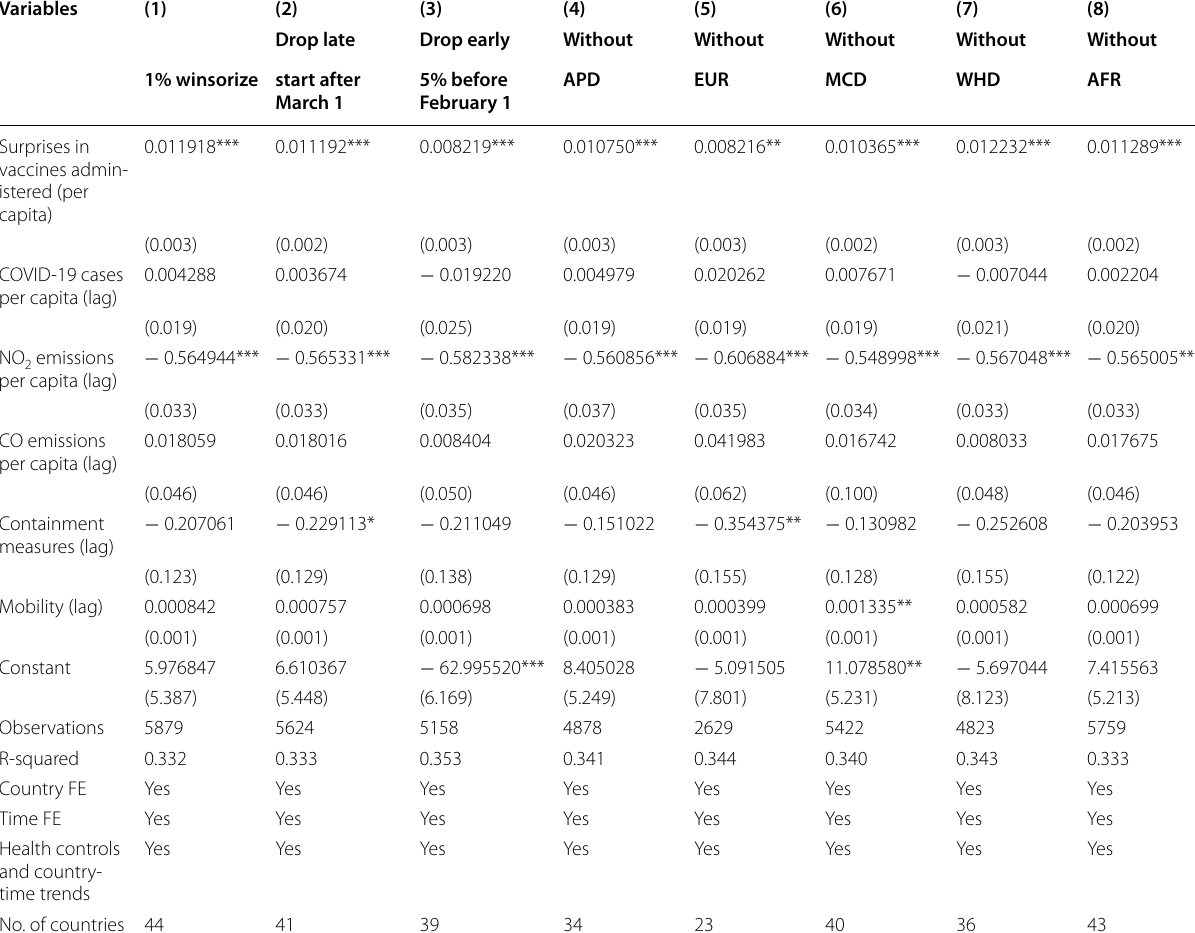
Table 10 Robustness checks—baseline using NO